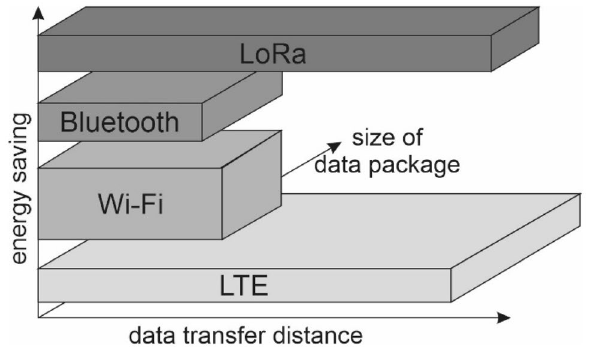
Figure 1. Schematic comparison of selected parameters (data transmission distance vs. energy efficiency) of the most popular wireless technologies on the